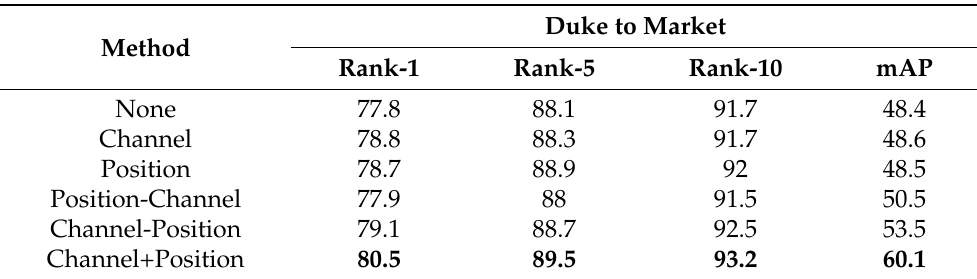
Table 2. An ablation study on DukeMTMC-reID to Market1501. The best accuracy is reached when channel and location attention are added.